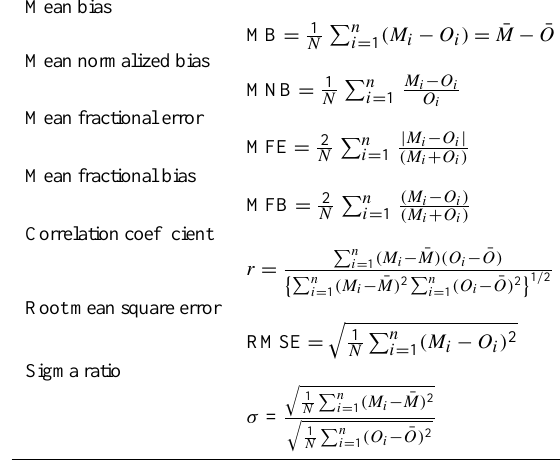
Table 3. Definition of the metrics used in the evaluation of the MOCAGE model performance. M refers to the model, O refers to P (M P (O ¯ O = 1 the observations. ¯ M = 1 i ) and i N N